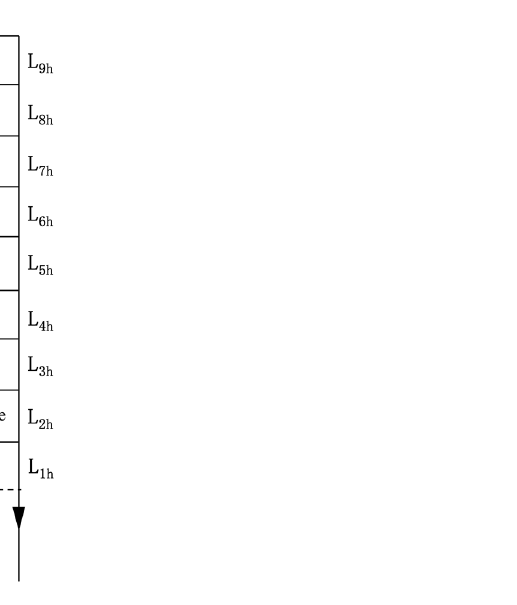
Figure 6. Composition of typical pipe network system. ACT represents the air conditioner terminal; L g represents water supply pipe; and L h represents water return pipe.